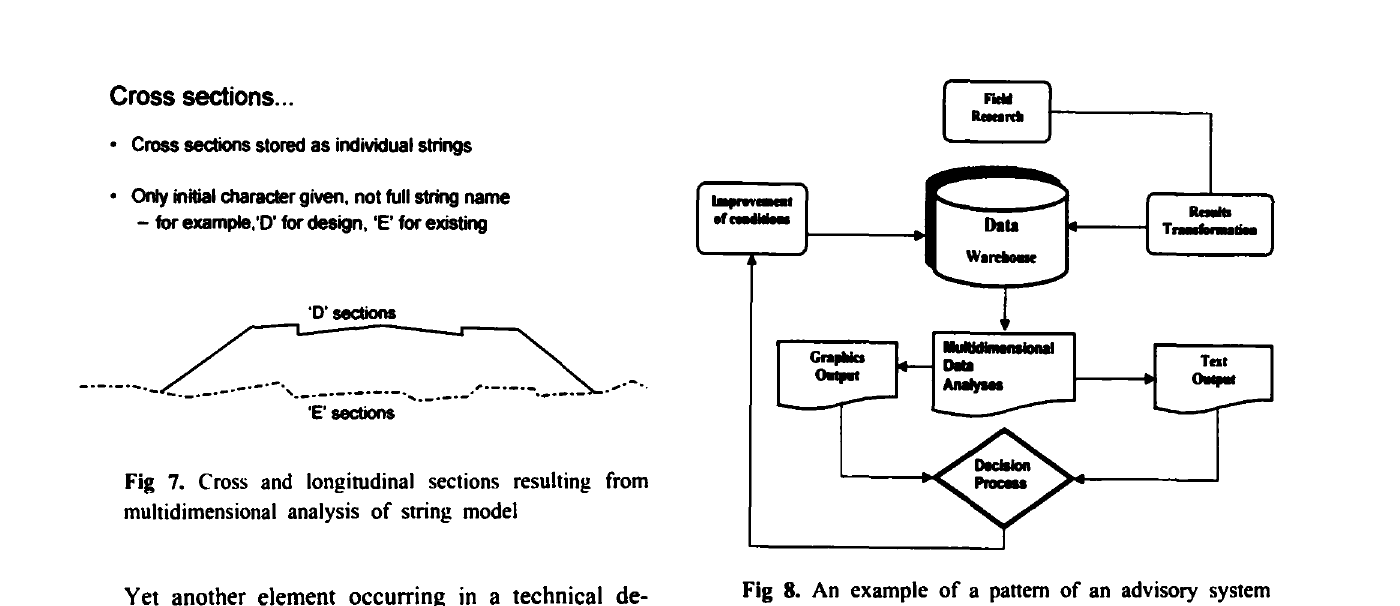
Fig 8. An example of a pattern of an advisory system using a multidimensional analysis